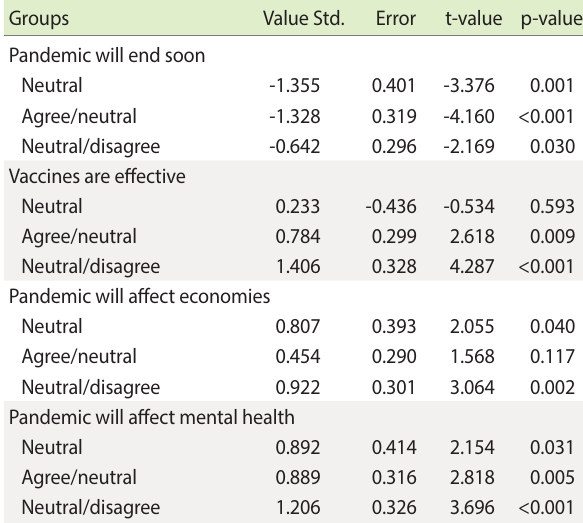
Table 2. Results of the ordinal regression models